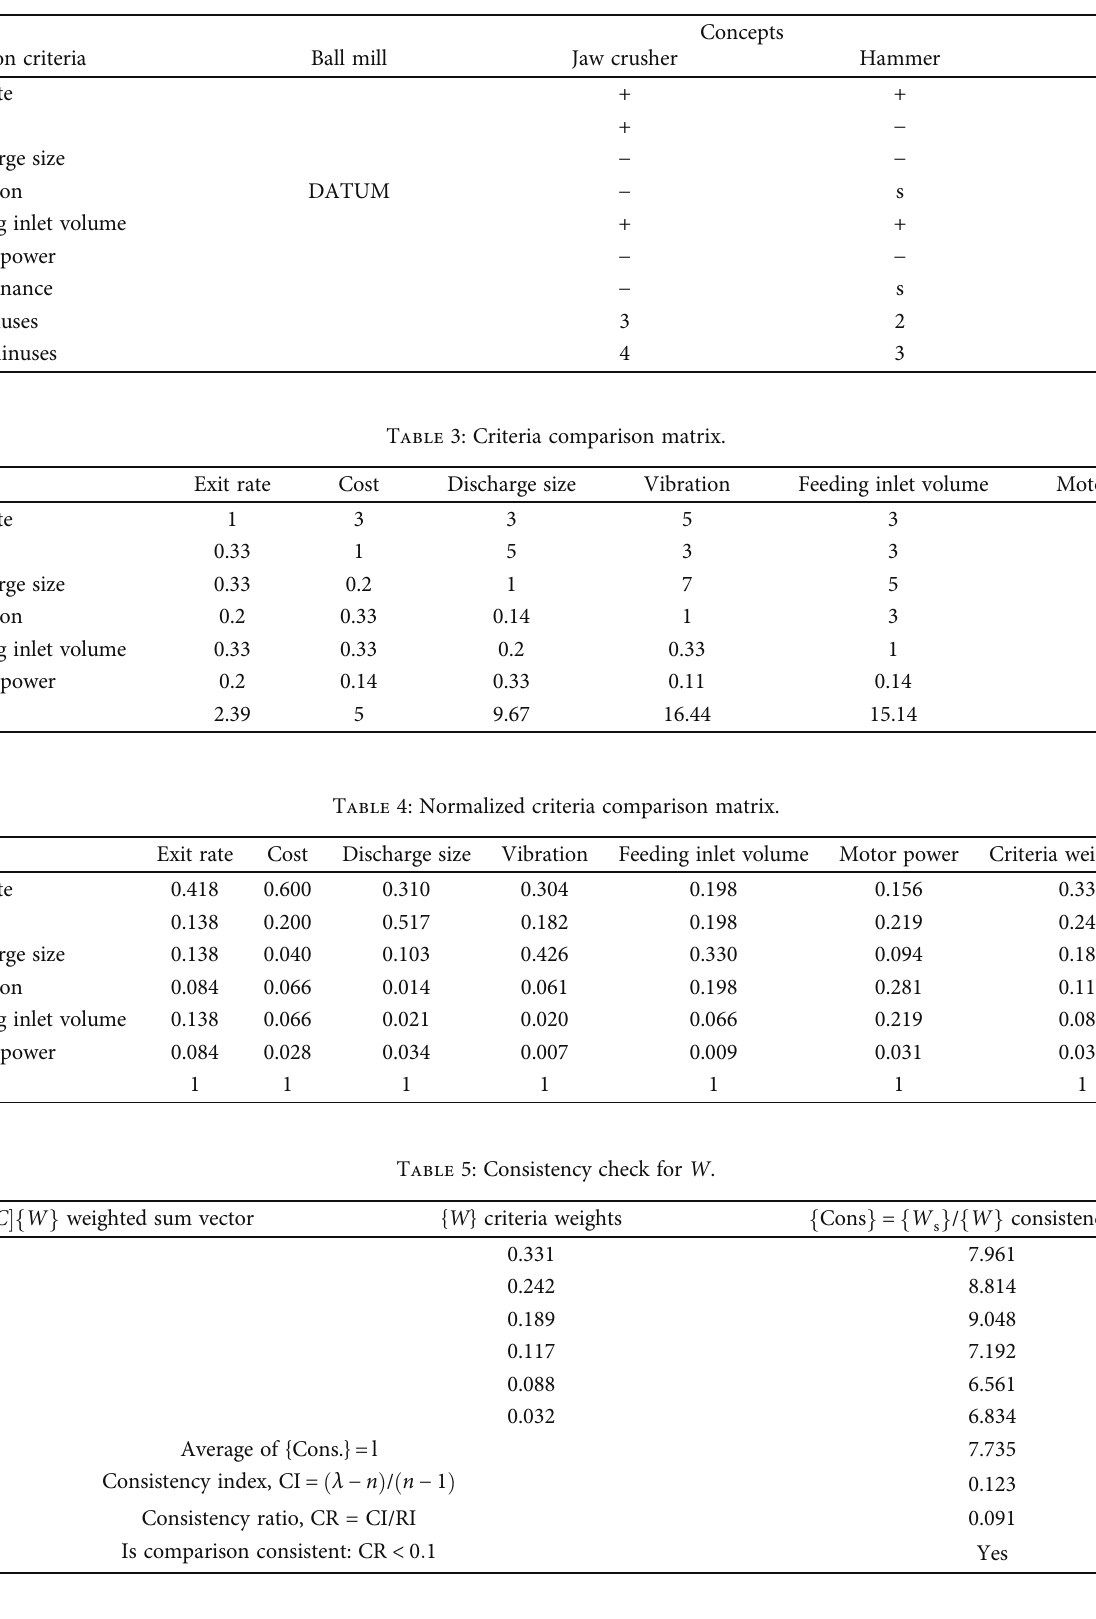
Table 2: Pugh chart.